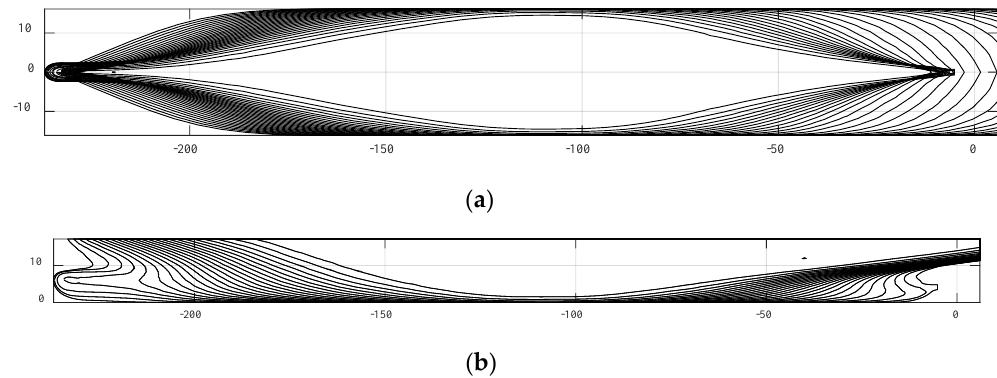
Figure 12. ( a ) Body plan of vertical slicing (KCS, 30 slices) ( b ) Body plan of transverse slicing (KCS, 50 slices).